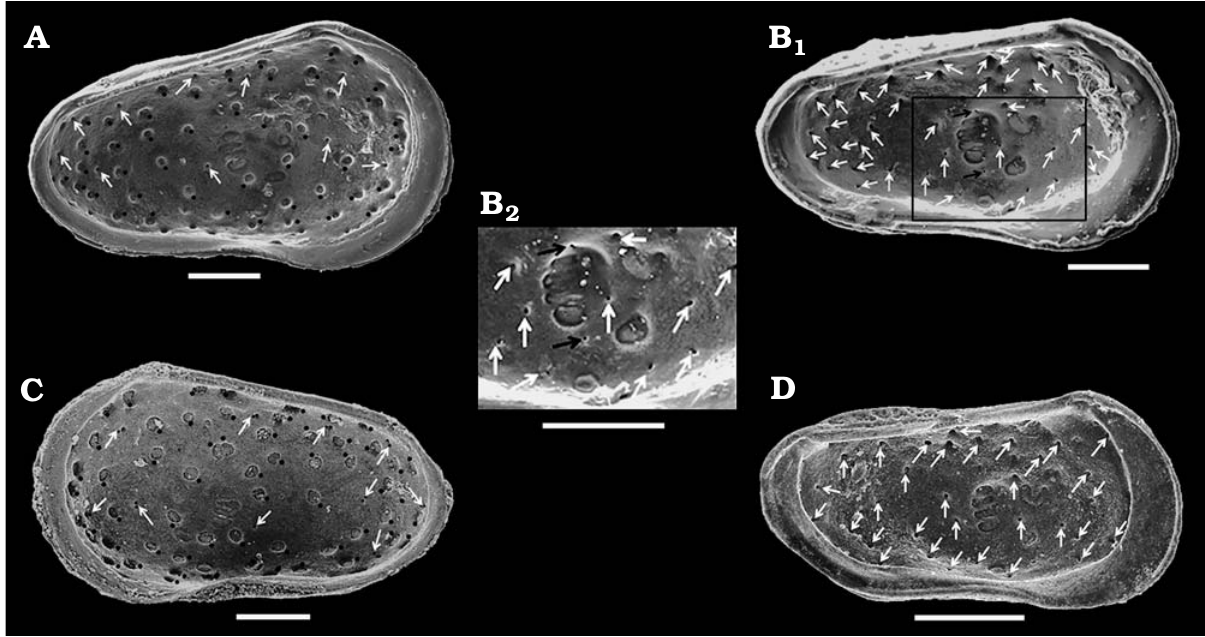
Fig. 11. Distribution of macro sieve-type normal pore canals (StPC-M), micro sieve-type normal pore canals (StPC-m), and simple normal pore canals (NPC) on the inner side of cytherid ostracods Minyocythere gen. nov. and Dolocythere Mertens, 1956. A . Minyocythere macroporosa sp. nov., holotype, SMF Xe 23721 from Borehole Hambühren WA2, 166 m, NW Germany, Witchellia laeviuscula Zone (Braun Jura γ ), Lower Bajocian; male left valve. B . Dolocythere rara Mertens, 1956, SMF Xe 23756 from Borehole Rodewald WA6, 206 m, NW Germany, Lower Albian; male left valve (B 1 ), detail (B 2 ). C . Minyocythere sp. cf. M . macroporos a sp. nov., SMF Xe 23724 from Borehole Rodewald WA12, 386 m, NW Germany, Upper Aalenian (Braun Jura β upper); male right valve. D . Dolocythere amphistiela sp. nov., paratype, SMF Xe 23765 from Borehole Rodewald WA4, 187 m, NW Germany, Leymeriella tradefurcata Zone, Lower Albian; male left valve. In A and C, black dots refer to StPC-M, white arrows point to StPC-m; in B 1 , B 2 , D white arrows point to NPC; black arrows in B 1 , B 2 indicate the peculiar pores of D. rara (which do not exist in D . amphistiela ). Scale bars 100 μ m.